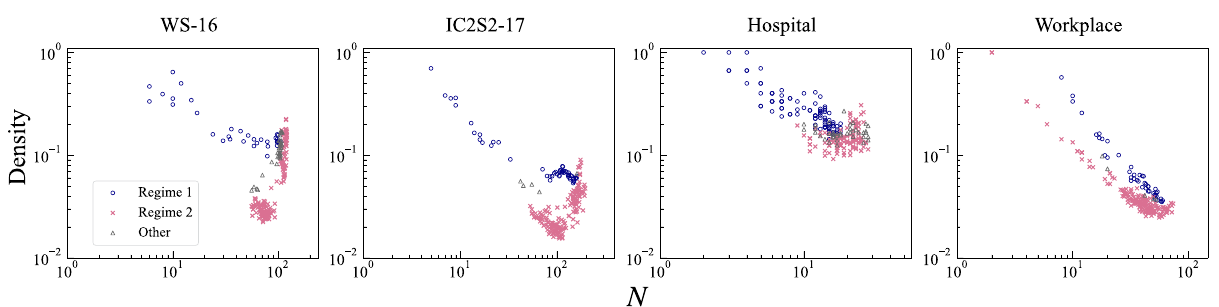
Figure 6. Density versus the number of active nodes. Classification of dynamical regimes is conducted in the same way as in Fig.